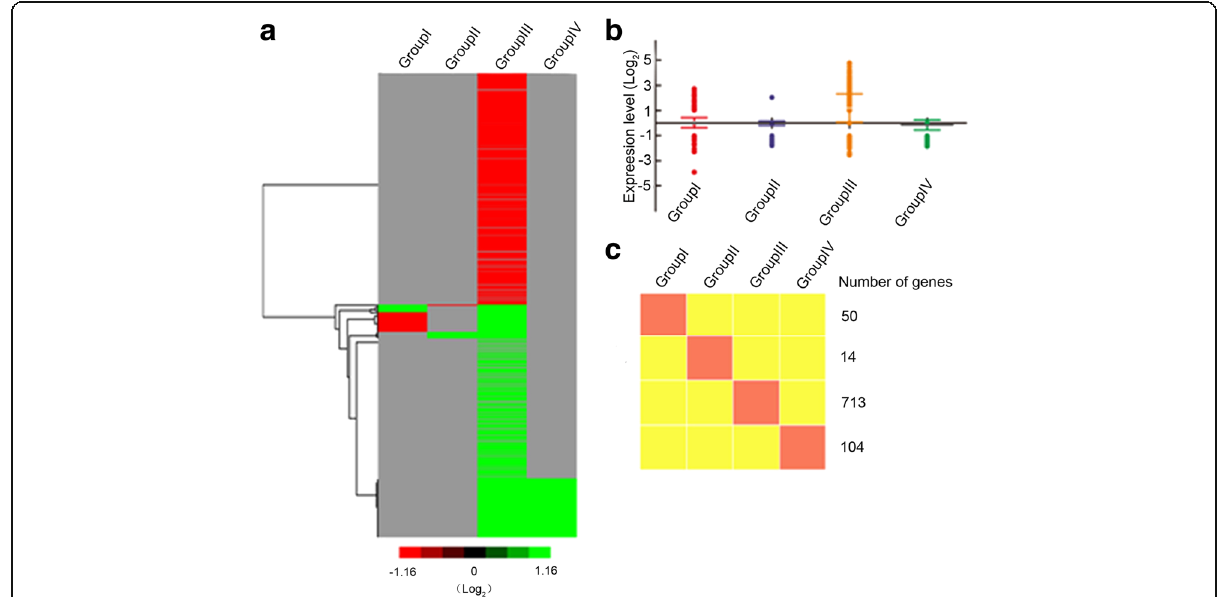
Fig. 6 Specific differentially expressed genes (DEG) associated with four comparison groups during meiosis. a Hierarchical cluster diagram represents expression patterns of DEG that specifically expressed in four different comparison groups. b Expression levels of specifically expressed DEG in four comparison groups. c A diagrammatic representation of the expression profiles of four comparison groups